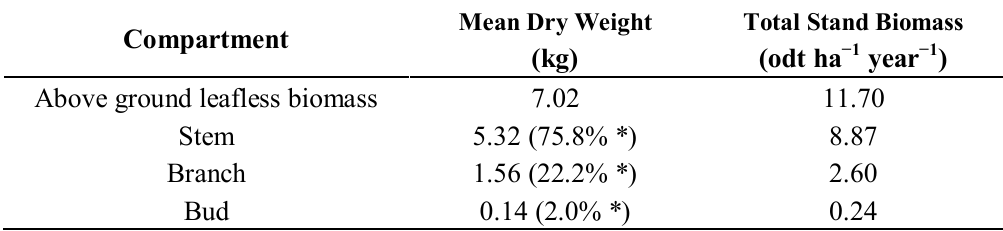
Table 5. Average biomass distribution after three years at tree and stand level (based on a mean dbh of 57.4 mm and a height of 724.3 cm).